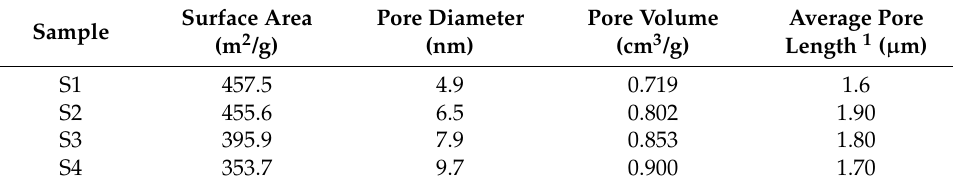
Table 1. Texture properties of 20% Co/SBA–15 catalysts.